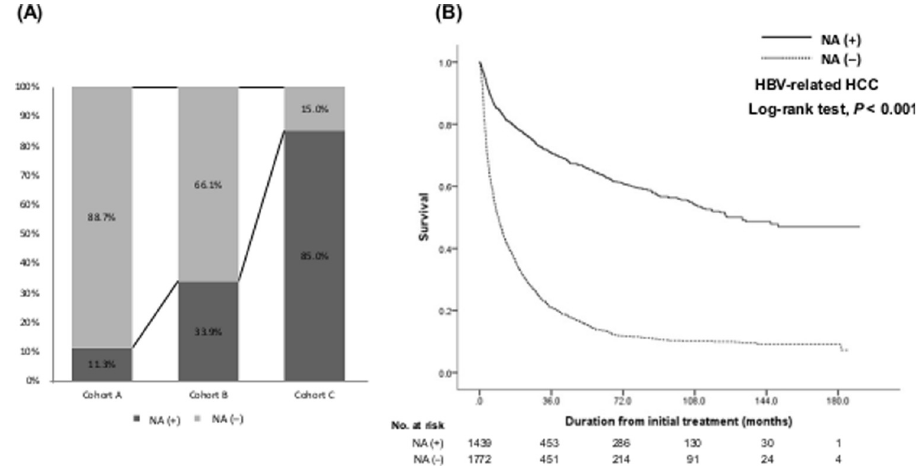
Fig 3. Proportion of patients who used nucleos(t)ide analogues (A) and the survival of patients according to the use of nucleos(t)ide analogues